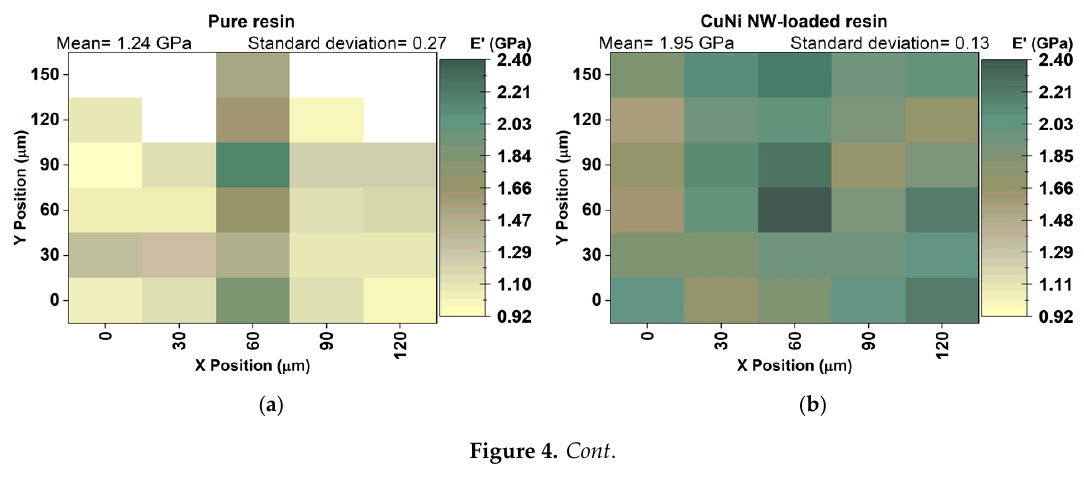
Figure 3. ( a ) 3D rendering of the CuNi NW-loaded resin and ( b ) magnification of the region in the red rectangle in ( a